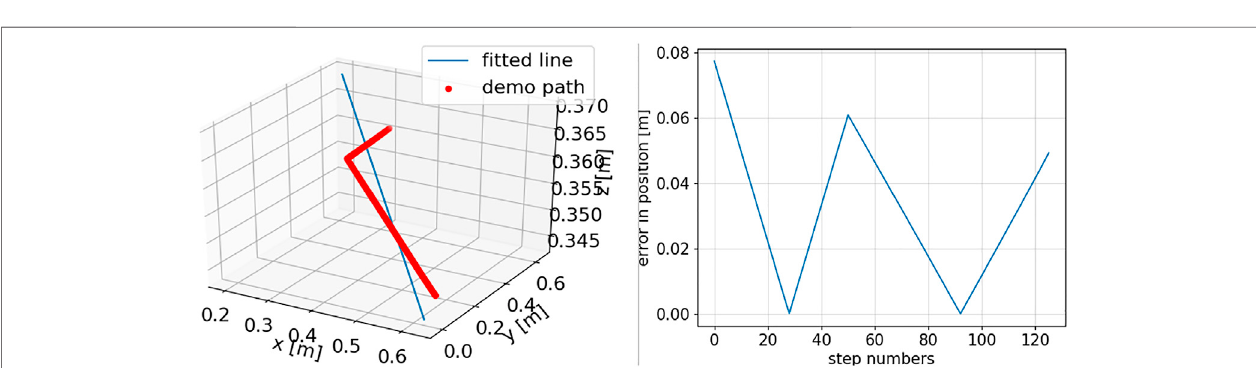
FIGURE5| Foronedemonstratedtrajectory:left,lineapproximationofthepositiondatabyminimizingtheleastsquareerrors;right,lineapproximationerrorsatthe different steps of the demonstrated trajectory.